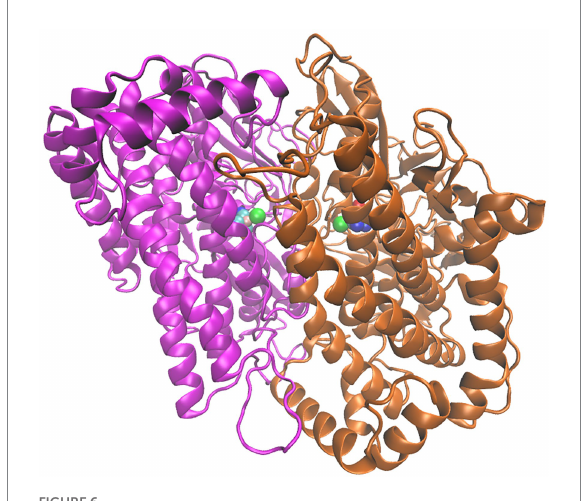
FIGURE 6 Structure of the HoxG homodimer (HoxG d ) taken from GaMD simulation at 150 ns. 232 [NiFe]-active sites are depicted as spheres following the color code: Fe in pink, Ni in green 233 CN − and CO groups, cyan-blue and cyan-red, respectively.